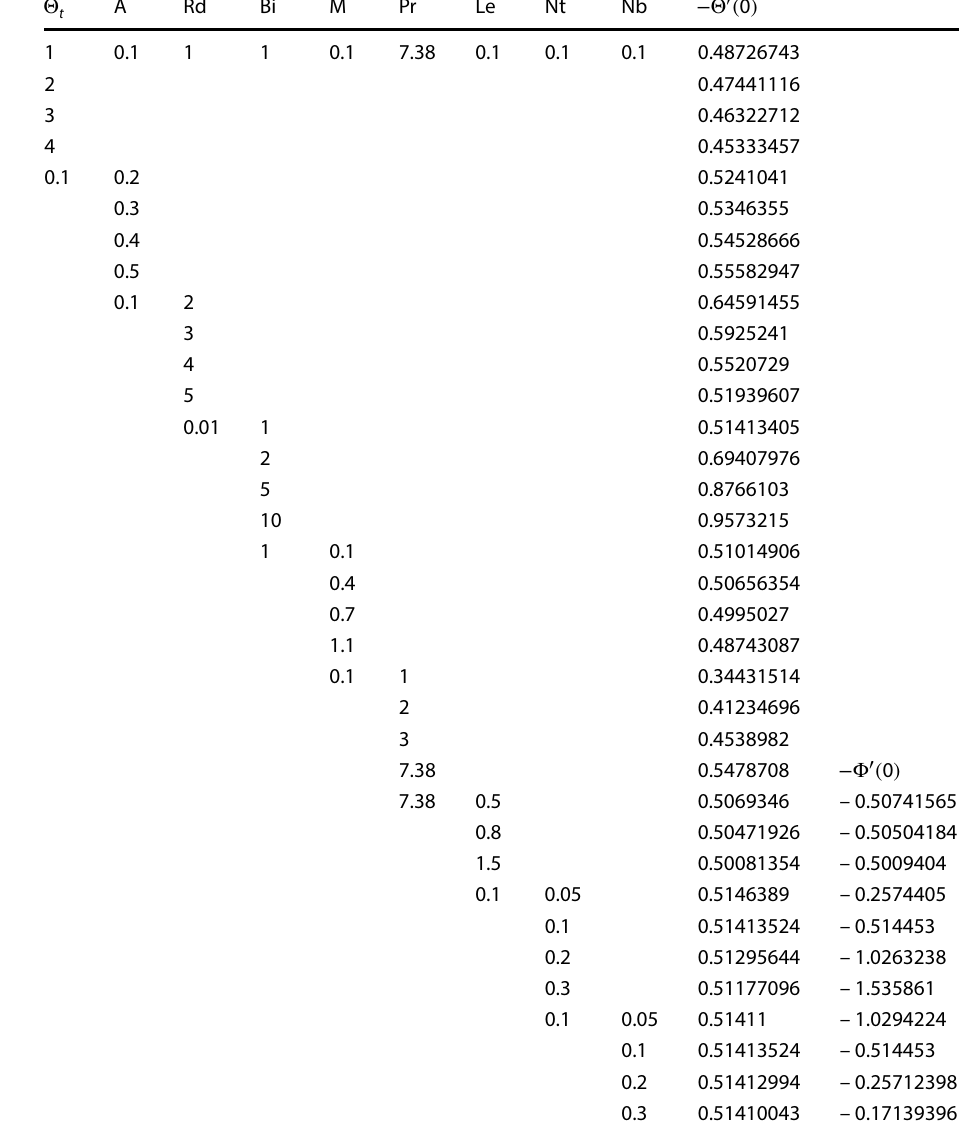
Table 3 Nusselt number and Sherwood number numerical data with E = 0.1, m = 2 , 𝛿 = 0.1 , Ec = 0.03 , 𝛾 1 = 0.3